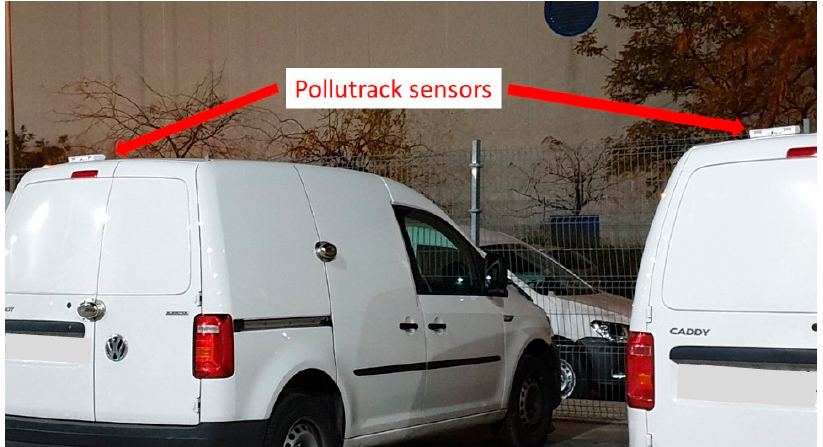
Figure 1. The Pollutrack sensor on the roof of vans.